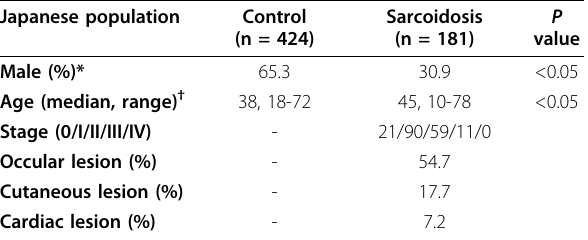
Table 2 Characteristics of 605 Japanese